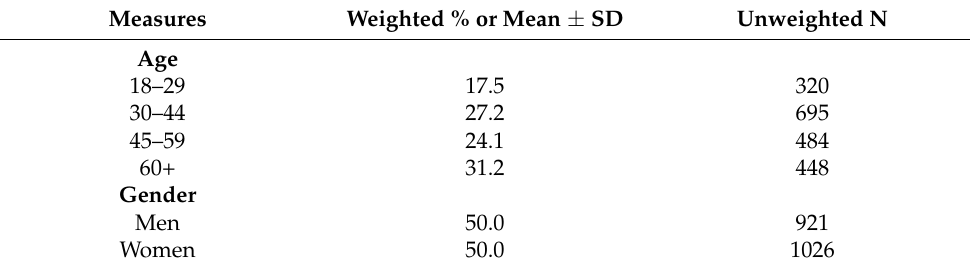
Table 1. Weighted and unweighted descriptive statistics for all study variables (N =